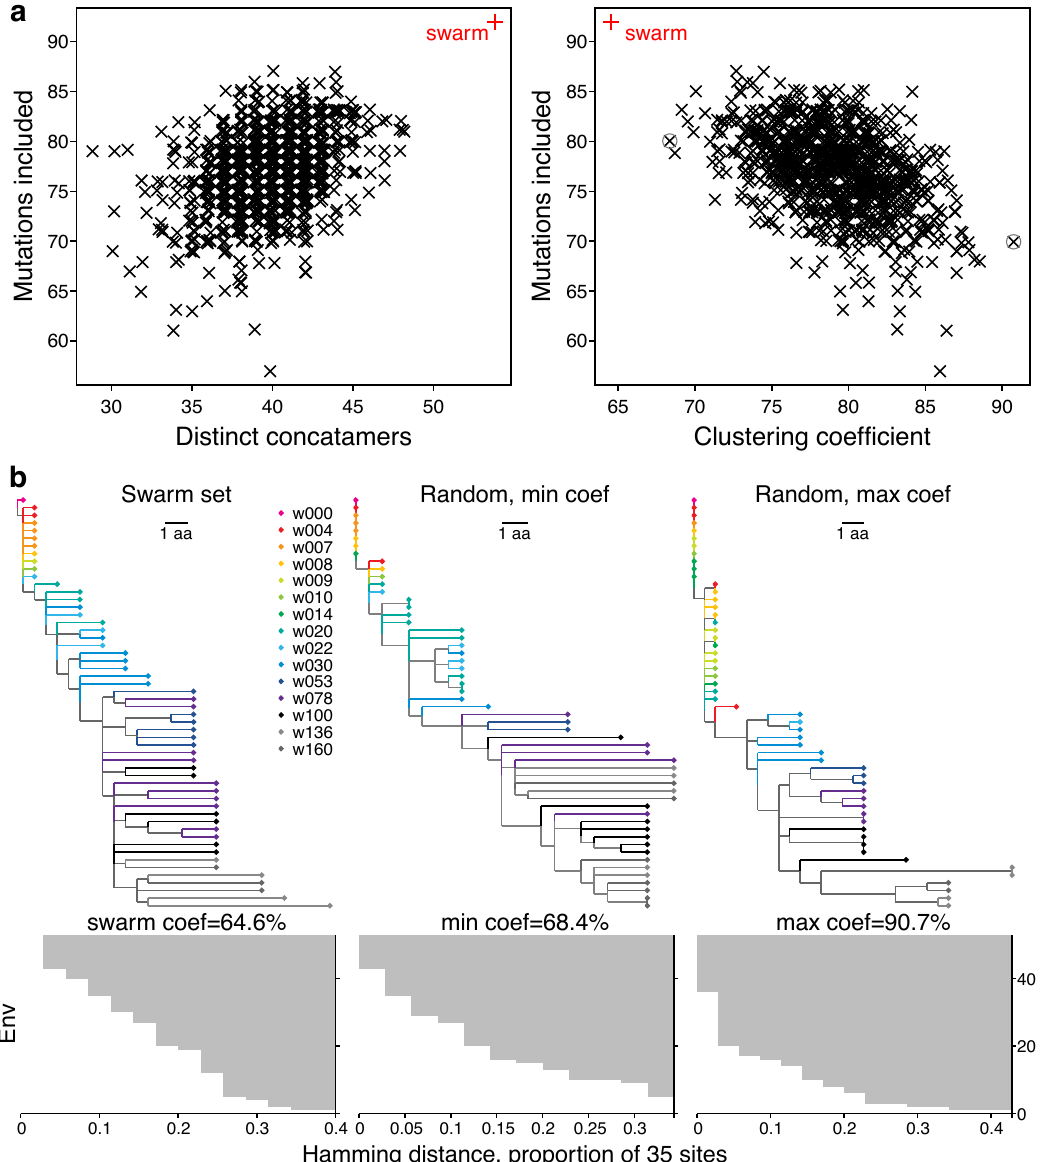
Figure 6. The selected swarm set is distinct from randomly selected sets. ( a ) Number of distinct concatamers, mutations included, and clustering coefficients from dendrograms of concatamer distances differ for the selected swarm of 54 Envs (red) and the null distribution from 1000 sets of 54 Envs, randomly selected without replacement from the non-redundant set of 260 viable full-length Envs, with the TF form always included. Values have jitter added for less overplotting; ( b ) Clustering coefficient quantifies sequence differences as the average normalized distance at which each sequence is merged into a cluster (horizontal grey bars in bottom row), compared for the selected swarm set two extreme randomly sampled sets (min and max, circled points in a ,